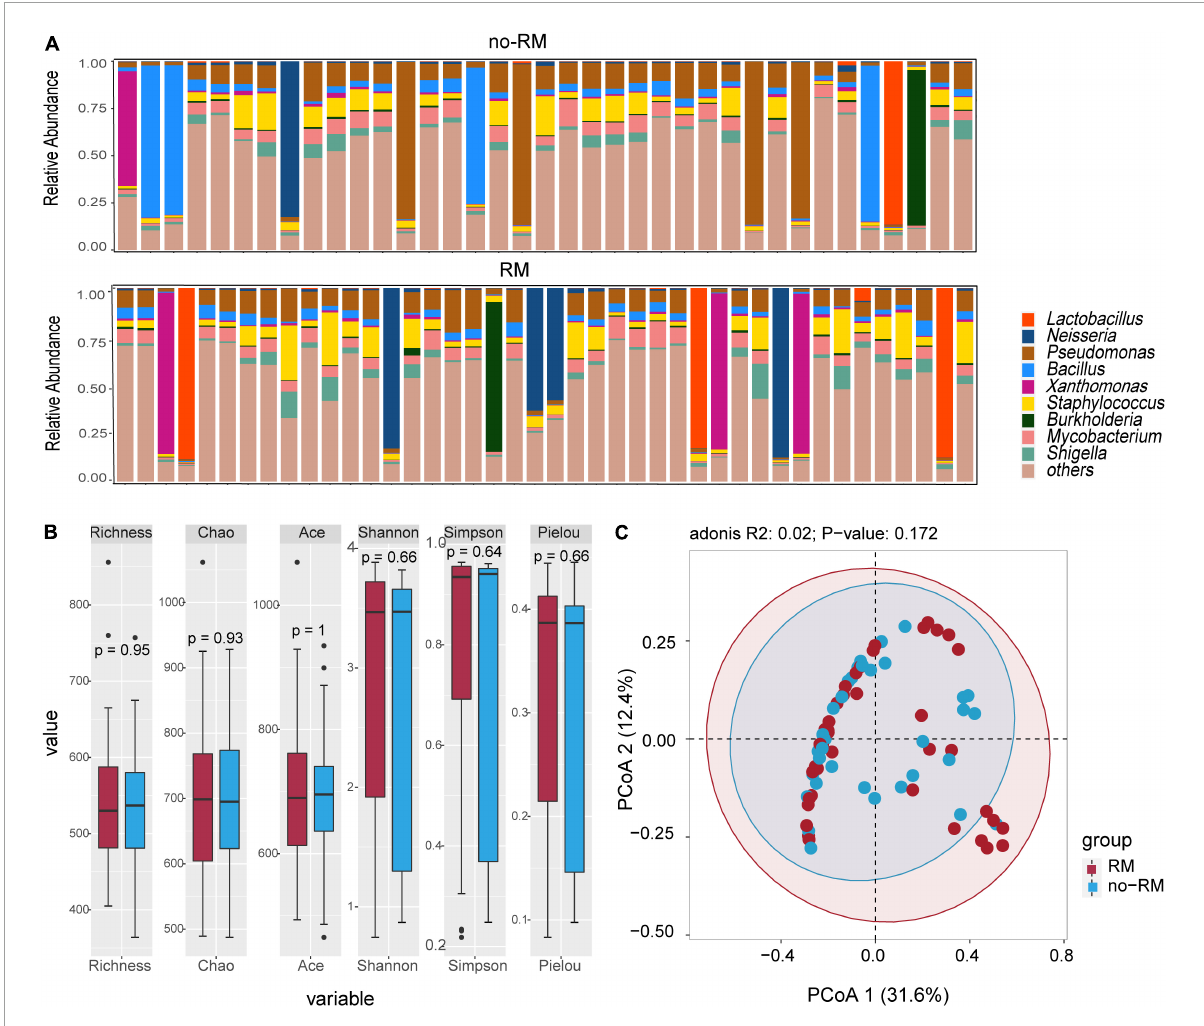
FIGURE2 Difference in microbial composition and diversity between the two groups. (A) The top 10 genus levels in two groups; the stacked bar chart showed the composition of patient genus level in two groups of recurrence or metastasis. (B) Comparison of alpha-diversity of two groups based on different indexes. (C) Comparison of beta-diversity of two groups with PCoA. Wilcoxon test was used to detect variation between different groups based on the microbial composition at the genus level. Richness, Chao, and Ace index represent the richness of the microbial species; Shannon, Simpson, and Pielou index represent the diversity of the microbial species; RM, recurrence and metastasis; no-RM, no-recurrence and